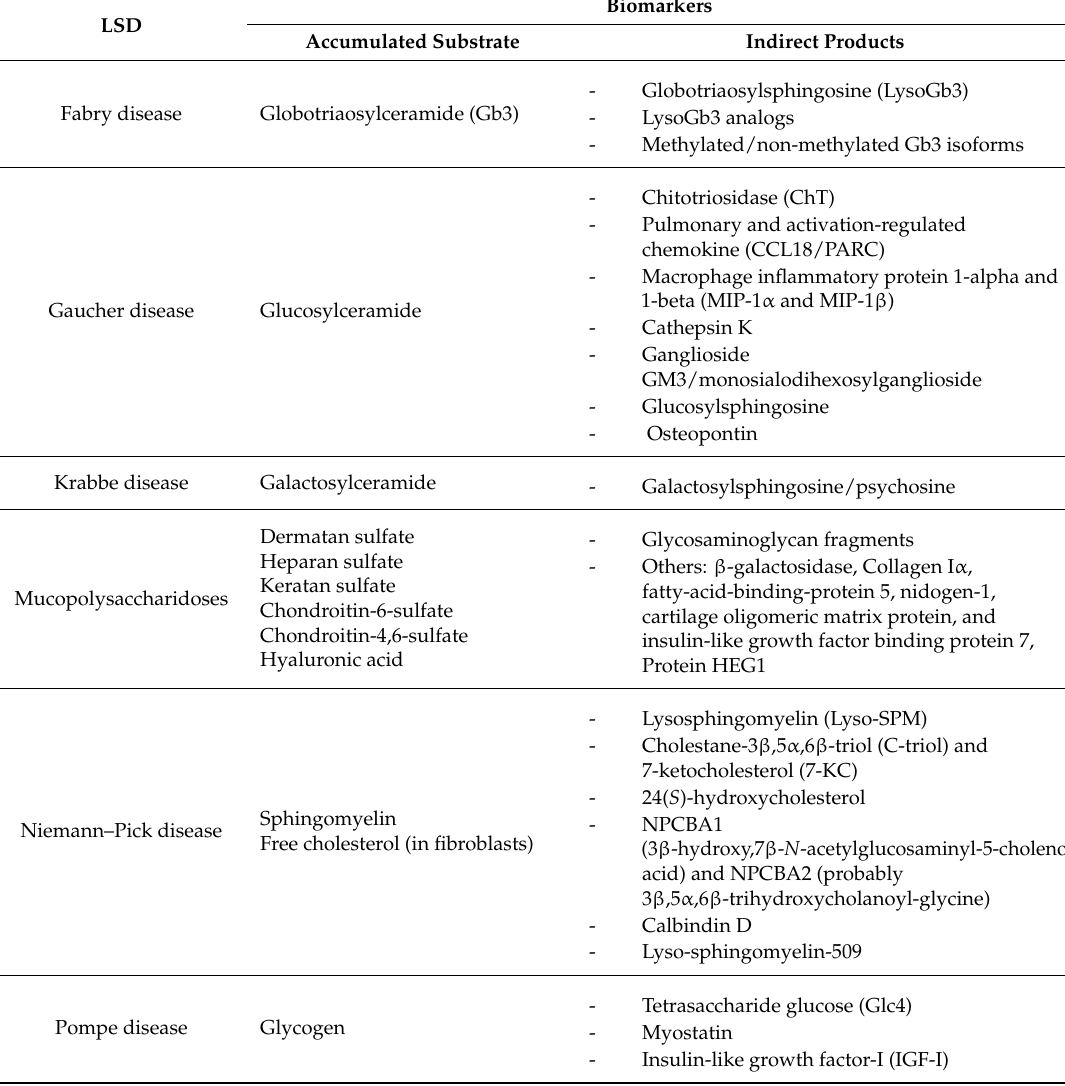
Table 2. Classification of biomarkers according to the nature of